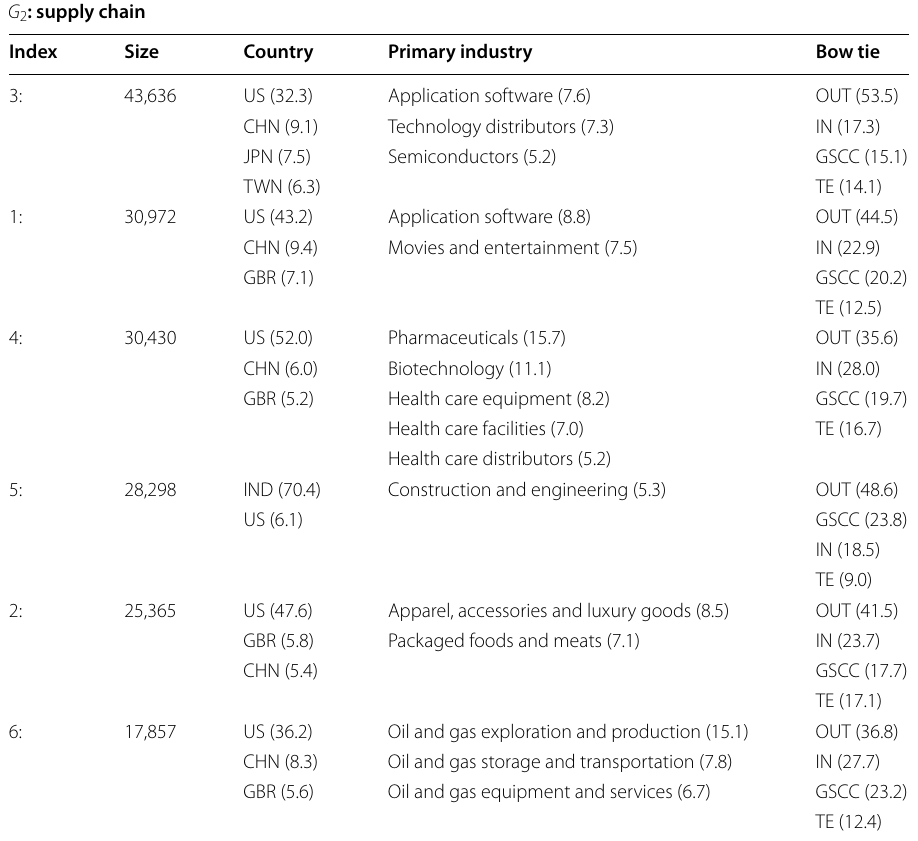
Table 9 Characteristics of the six largest communities at the first level for the supply chain layer